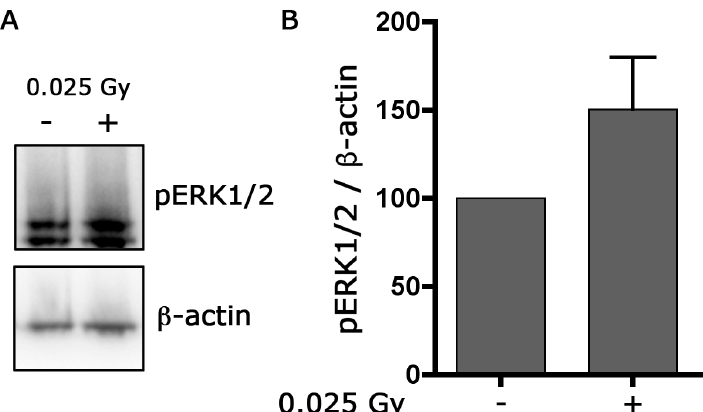
Figure 7. The priming dose increases the expression of p-ERK1/2. Cultures were irradiated with a priming dose (0.025 Gy) and collected after 4 h. Whole-cell lysates were prepared from retinal cultures. ( A ) Equal amounts of total protein from each lysate were resolved on 10% SDS-PAGE and transferred to nitrocellulose membranes. Membranes were probed with anti-rabbit polyclonal anti- phospho-ERK1/2. β -actin levels were used as a control of protein loading. Blots are representative of three independent experiments. ( B ) Bar graphs represent the mean ± SEM from three independent experiments as in ( A ).